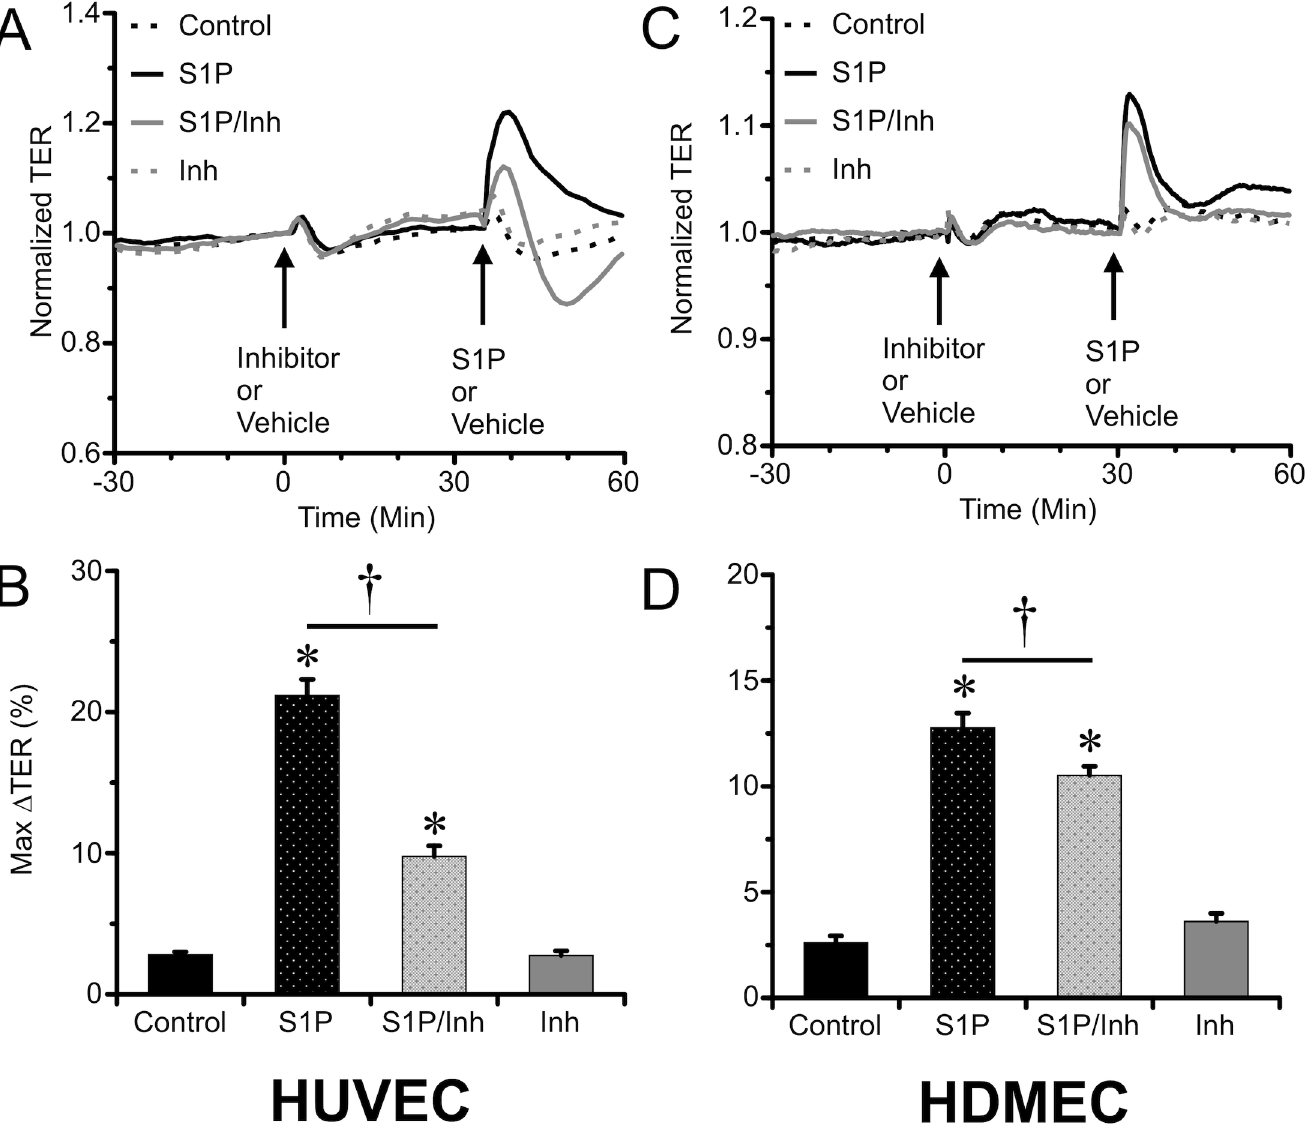
Fig 6. Inhibition of RhoA attenuated S1P-induced barrier enhancement of endothelial monolayers. A . The time course of changes in of TER of HUVEC monolayers pretreated with the 30 min with the combination of Rhosin and Y16 (5 μ M of each) or vehicle control, followed by treatment with 2 μ M S1P or vehicle (N = 8 for each group). B . Comparison of the mean maximal changes in TER of HUVEC monolayers (%) within the first 10 min after S1P or vehicle. The corresponding results for HDMEC monolayers are shown in panels C & D (N = 8 each group). * P < 0.05, S1P vs. vehicle treated group. † P < 0.05, inhibitor vs. vehicle